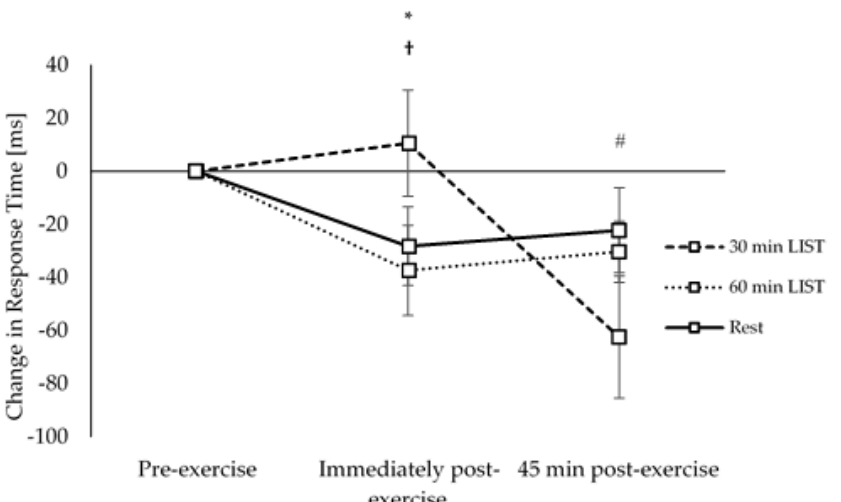
Figure 4. Change in response times across the morning on the 30 min LIST, 60 min LIST, and resting control trials on the one-item level of the Sternberg paradigm. Slower response times following 30 min LIST vs. 60 min LIST * and rest †; faster response times following 30 min LIST vs. rest # ; all p < 0.05.